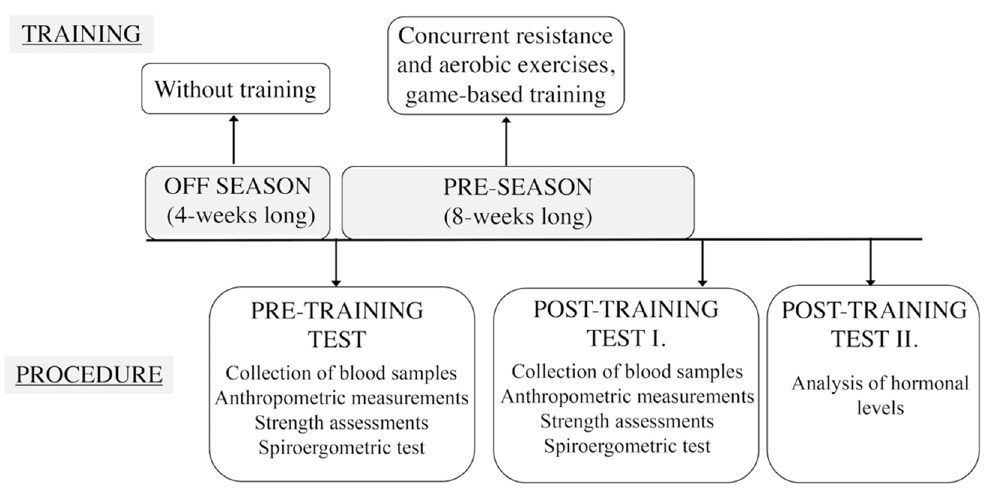
Figure 1. Exercise bout and measurements performed during the experiment.